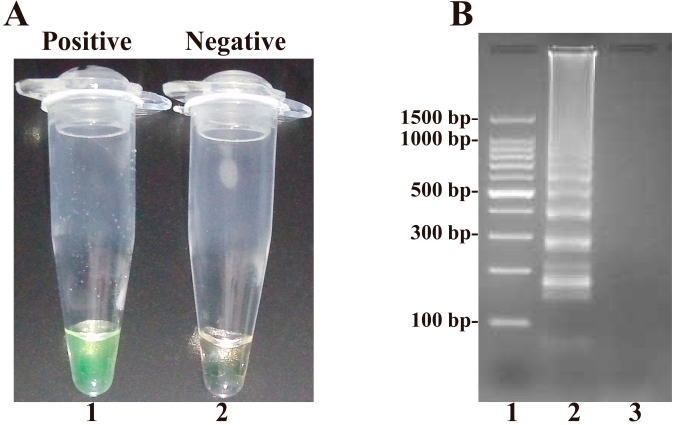
Figure 1. Result of the LAMP on detection of B. quintana (str. Toulouse): ( A ) color change of the